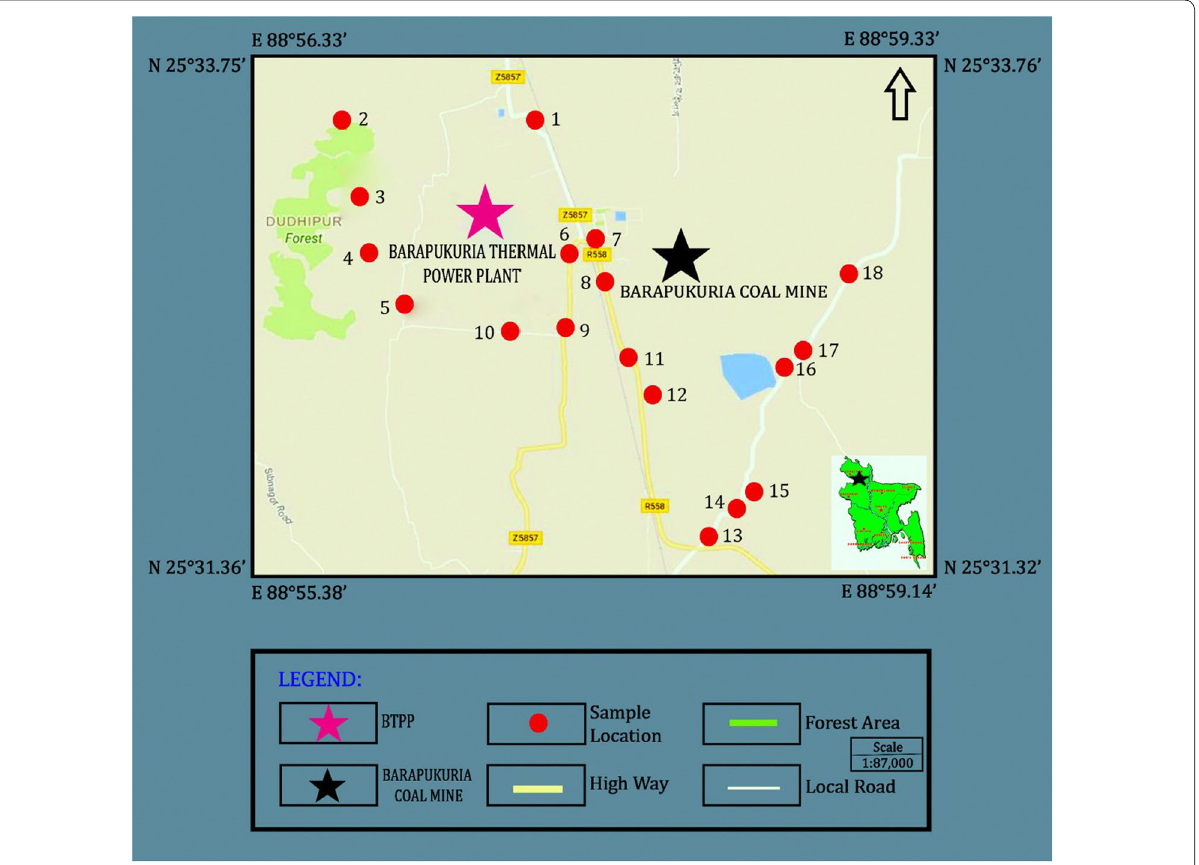
Fig. 1 Index map showing the collected samples